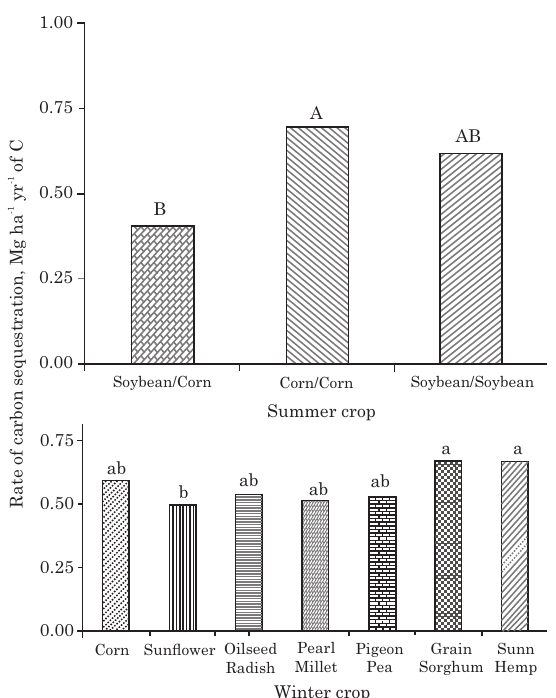
Figure 2. Rate of carbon sequestration in an Oxisol under summer and winter cropping sequences in a no- till system. Same letters above the bars are not significantly different by theTukey test